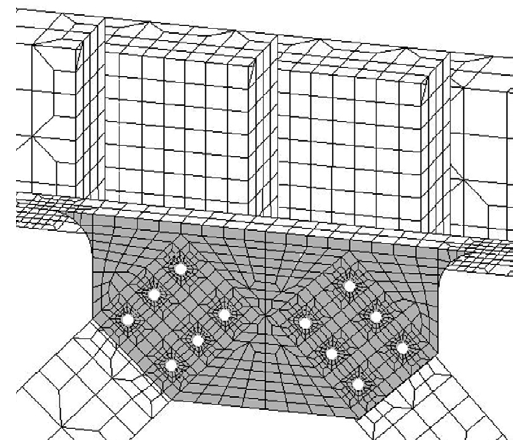
Fig. 19. Model S (up to symmetry plane)